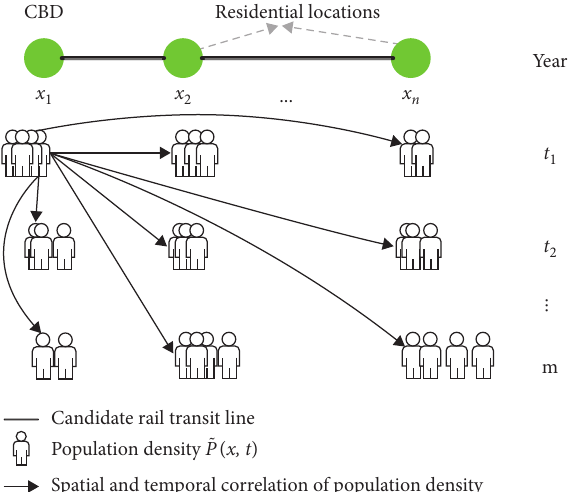
Figure 1: Spatial and temporal correlation of population densities in a candidate rail transit line over